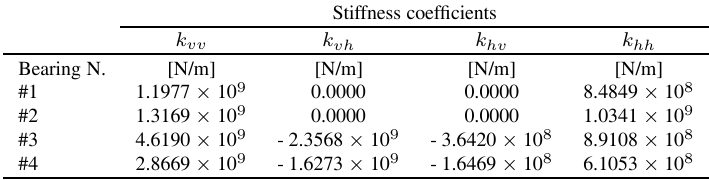
Table 3 Oil- fi lm stiffness coef fi cients of bearings from #1 to #4, evaluated at 3000 rpm